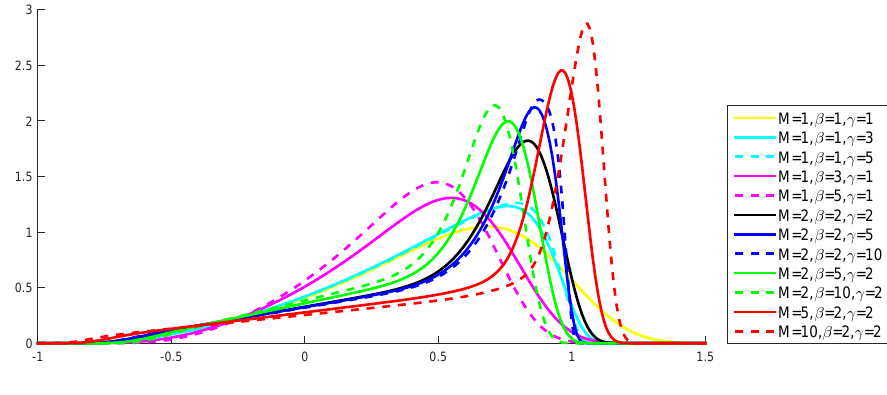
(b) The pdf of the maximum statistic for the same parameters as in Figure 9(a). Figure 9: The l 3,5 -symmetric Kotz type sample